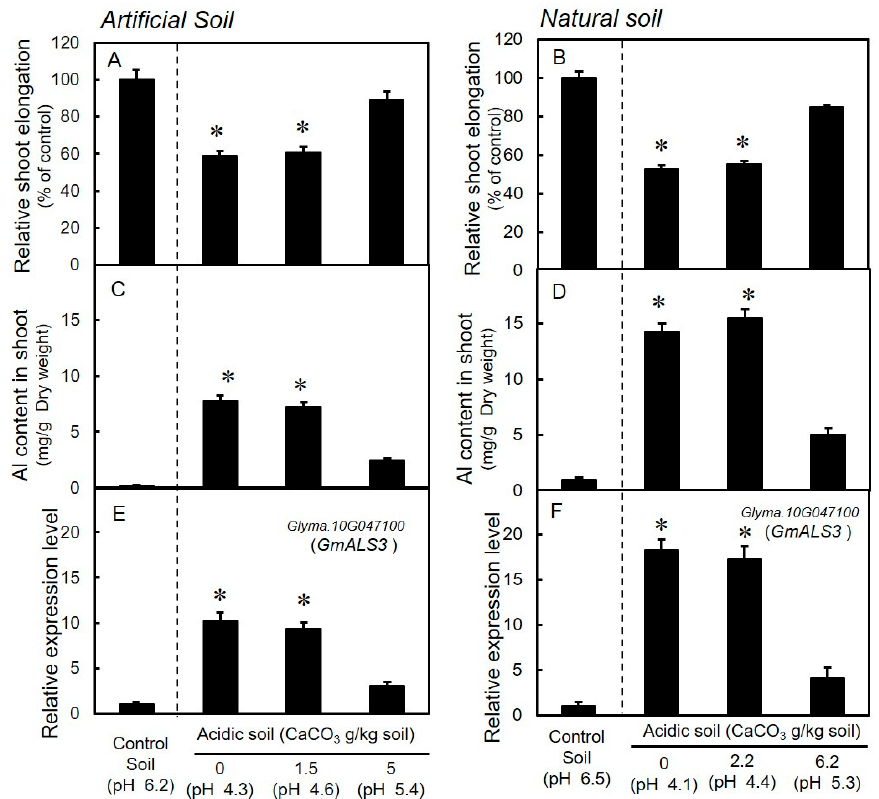
Figure 3. Growth and expression levels of GmALS3 in soybeans grown in artificial and natural soils with different levels of CaCO 3 . Plants were grown for two weeks in neutral soil (addition of 2 g CaCO 3 g/kg soil) as a control and in acidic soil with the addition of different levels of CaCO 3 (0, 1.5 and 5 g/kg soil for artificial acidic soil; 0, 2.2 and 6.2 g/kg soil for natural acidic soil) as a treatment; ( A ) Relative shoot elongation of soybeans grown in artificial soils; ( B ) relative shoot elongation of soybeans grown in natural soils; ( C ) Al content of in the shoots of soybeans grown in artificial soils;